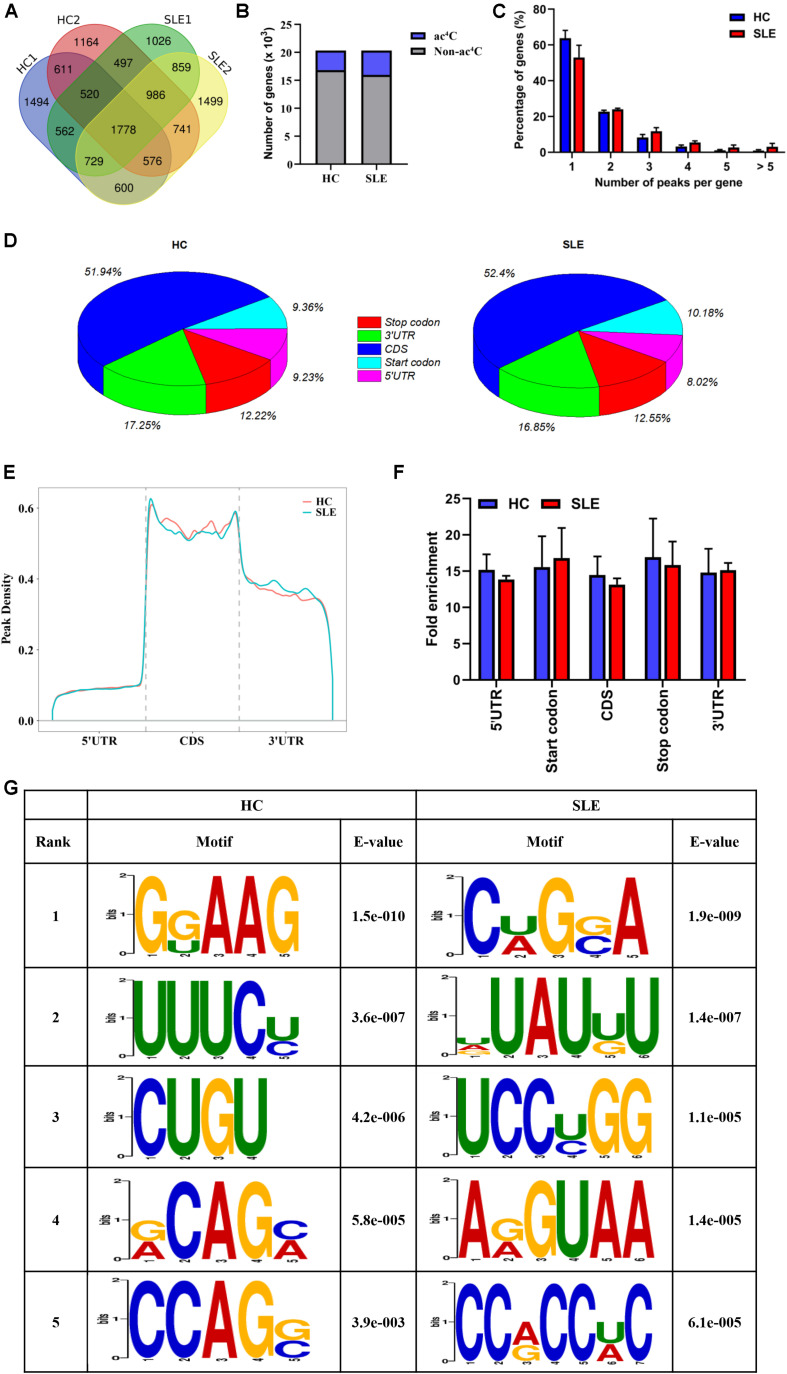
Transcriptome-wide ac4C-RIPSeq and distribution of ac4C peaks. (A) Venn diagram of ac4C acetylated genes in HCs and SLE patients. The numbers of HC-unique, SLE-unique, and common ac4C modified genes are shown. (B) Bar charts indicating the number of genes with no (gray) or at least one significant (blue) ac4C peak at SLE group or HC group. (C) Proportion of genes harboring different numbers of ac4C peaks in the two groups. The majority of transcripts harbor only one or two ac4C peaks per gene in HC and SLE groups. (D) Pie charts show ac4C peaks distribution in different gene context in HCs and SLE patients. The averages of percentages of mRNA ac4C peaks within 5′UTR, StartC, CDS, StopC, and 3′UTR regions in transcriptomes are shown. (E) Distribution of ac4C peaks along mRNA transcripts. The moving averages of percentages of mRNA ac4C peaks are shown. (F) Statistics of fold enrichment of ac4C peaks in five segments in the two groups. Error bars represent the mean with SD. (G) Sequence logo showing the top five differential mode motifs enriched across changed ac4C peaks identified from HCs and SLE patients.